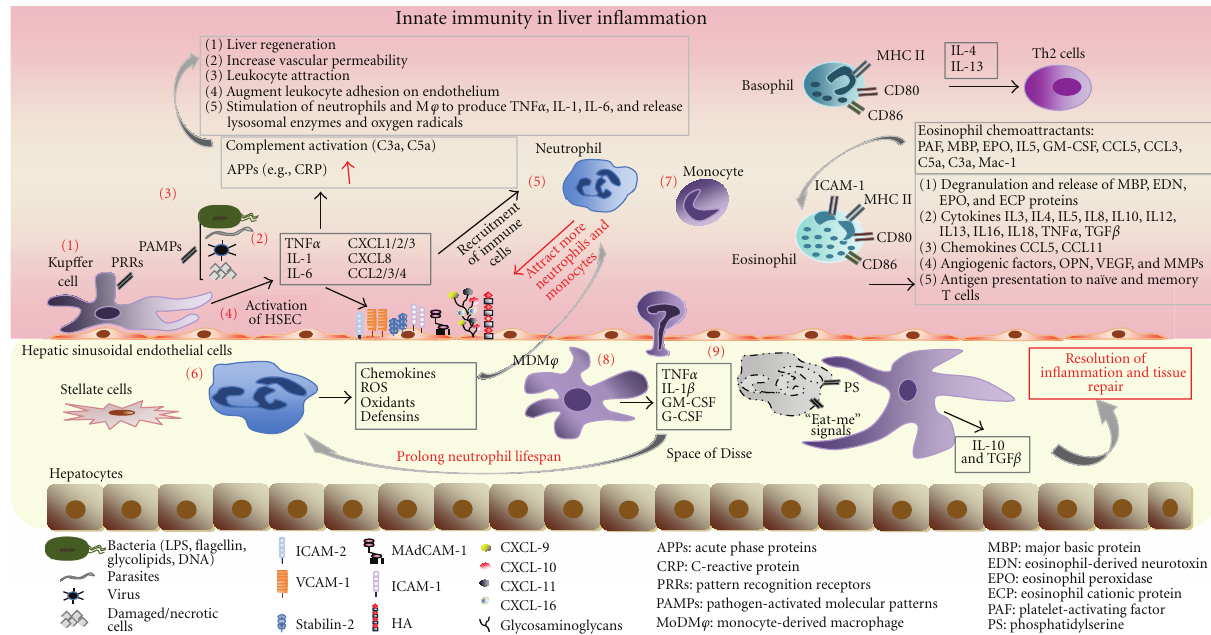
Figure 1: Innate immune cells in liver inflammation. During an infectious insult in the liver (1) resident macrophages, Kup ff er cells, are the first immune cells to detect the presence of invading pathogens (bacteria, parasites, viruses, damaged, and/or necrotic cells) via PRRs/PAMPs. (2) Upon activation Kup ff er cells release cytokines TNF α , IL-1, and IL-6 as well as chemokines CXCL 1–3, CXCL-8, CCL-2–4 that initiate (3) the acute-phase response and inflammation. Acute inflammation is characterized by the rise in plasma proteins, collectively named acute- phase proteins (APPs) that include C-reactive protein (CRP) and complement components. (4) Proinflammatory cytokines released from activated Kup ff er cells can activate hepatic sinusoidal endothelial cells to upregulate adhesion molecules (ICAM1 and 2, VCAM-1, MAdCAM etc.) and in combination with the chemokines secreted from Kup ff er cells can stimulate the recruitment of neutrophils and monocytes to the liver. (5) Neutrophils are the initial phagocytes to arrive at the site of microbial invasion, where (6) they change their phenotype, they become activated and release powerful and cytotoxic antimicrobial molecules such as reactive oxygen species (ROS), oxidants, defensins, as well as chemokines to attract more neutrophils and monocytes. (7) Following their recruitment to the tissue, monocytes undergo di ff erentiation into (8) tissue macrophages (MDM ϕ ), which release TNF α , IL-1 β , G-CSF, and GM-CSF factors that can extend the lifespan of neutrophils thus sustaining their presence at the site of inflammation. (9) In order for inflammation to be resolved, the dangerous neutrophils at the inflammatory loci undergo apoptosis and terminate the inflammatory process quickly. Apoptotic neutrophils represent an important anti- inflammatory stimulus to other cells involved in the resolution of inflammation by producing “eat-me” signals recognised by the surrounding phagocytes. Phosphatidylserine (PS) residues on the apoptotic neutrophil membrane allow recognition by its receptor on macrophages, which not only initiates phagocytosis but also modifies the transcriptional profile of the M ϕ , increasing the production of IL-10 and TGF-b, cytokines associated with resolution of inflammatory response and tissue repair. Basophils are short-lived cells that express MHC II and CD80/CD86 costimulatory molecules, thus are able to present antigens to CD4+ T cells promoting their di ff erentiation into Th2 cells via release of IL-4 and IL-13. Eosinophils recruited to the liver release proinflammatory mediators including granule-stored cationic proteins, cytokines, and chemokines. They also express MHC II, CD80/CD86, CD40, and ICAM-1; thus they are able to present antigens to T cells initiating or amplifying antigenic-specific immune